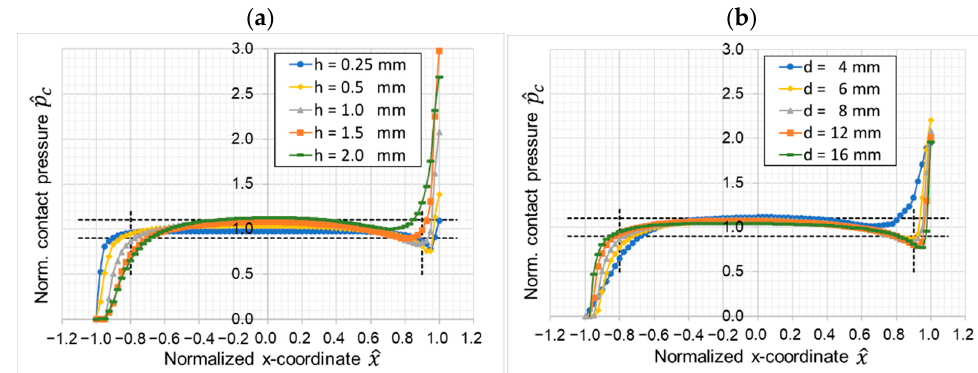
Figure 8. Variation of sample geometry ( a ) variation of height; ( b ) variation of diameter.